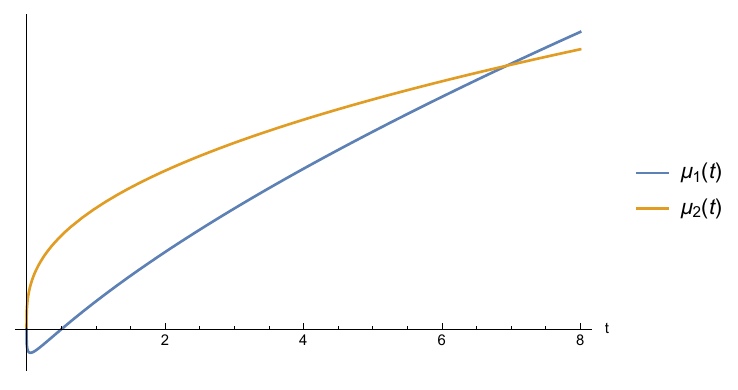
Fig. 8 The solutions of the initial value problem 40–41 for α = 0 .